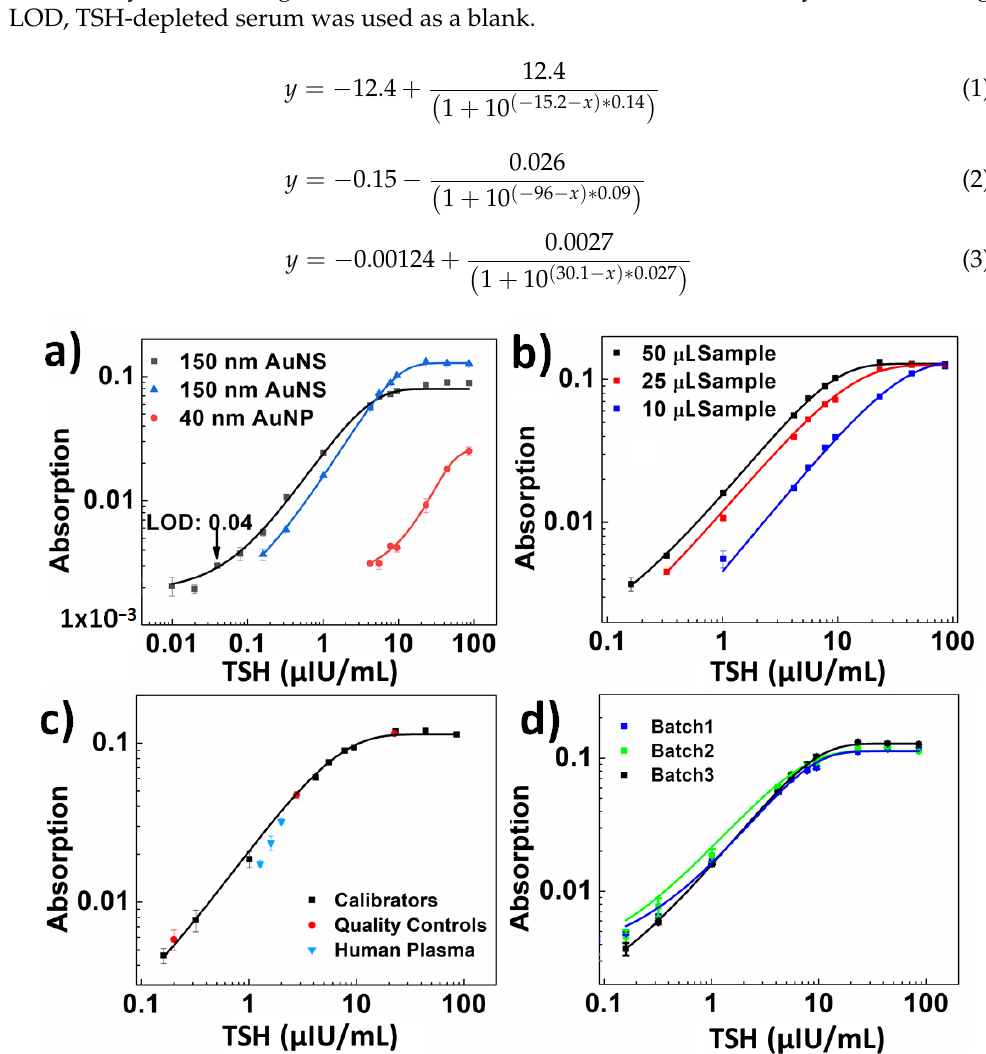
Figure 3. ( a ) Calibration curves for gold-nanoshell- and gold-nanoparticle-based LFAs with 50 µ L of TSH calibrators. The calibration curve (black) obtained with gold nanoshells using DI water as blank showed an LOD of 0.04 µ IU/mL. The calibration curve (blue) obtained with gold nanoshells using TSH-depleted serum as blank showed an LOD of 0.16 µ IU/mL. ( b ) Calibration curves of gold-nanoshell-based LFAs with 10, 25, and 50 µ L of TSH calibrators. ( c ) Calibration curve of gold- nanoshell-based LFA with 50 µ L of TSH calibrators, quality controls, and human plasma samples. ( d ) Reproducibility of calibration curves on three different batches of TSH